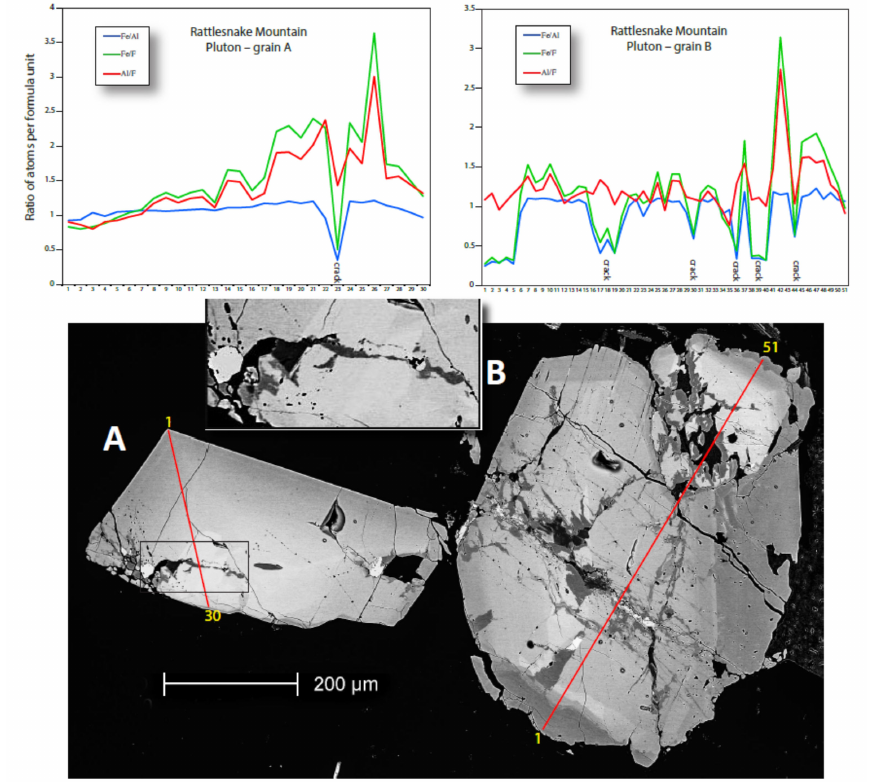
Figure 14. Top: Fe/Al, Fe/F, and Al/F ratios along electron microprobe traverses in two titanite grains (A and B) in a thin section of the Middle Jurassic Rattlesnake Mountain granite in southern California. Grain A has 30 analyses along the traverse and grain B has 51 analyses. Part of grain A (box) is blown up to give a better view of the dark titanite along the crack. Grain B has some open (plucked) black spaces along the traverse at the top right of the photo and a dark gray recrystallized or overgrowth section at the lower left of the grain from microprobe point 1 to about point 6 that is high in